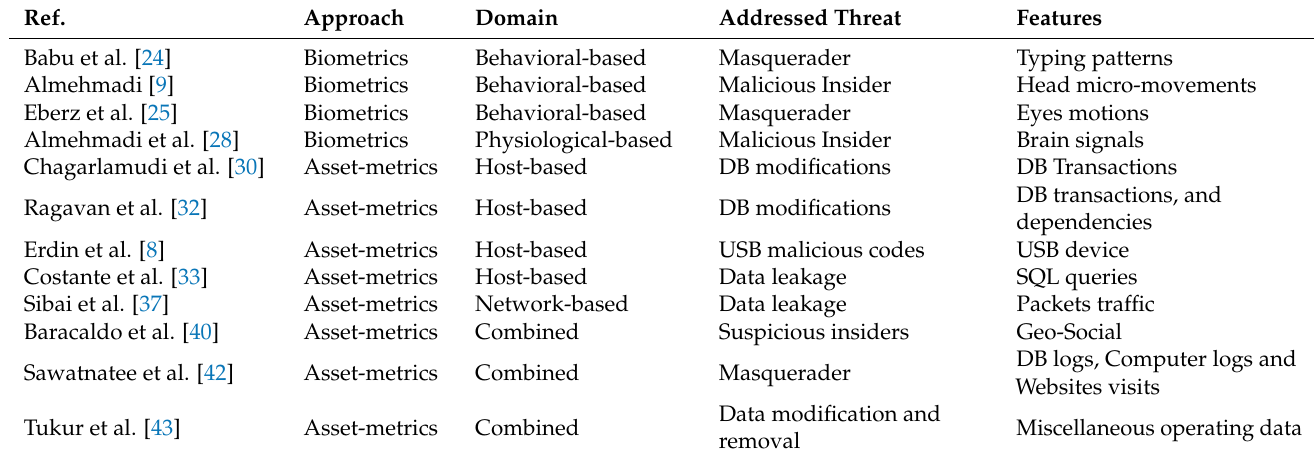
Table 1. A summary of ITP